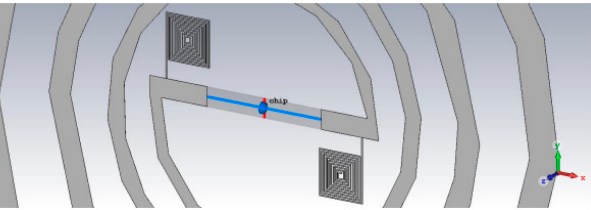
Figure 6. The electromagnetic design of the spiral antenna integrated with an RFID chip impedance adaptation network.